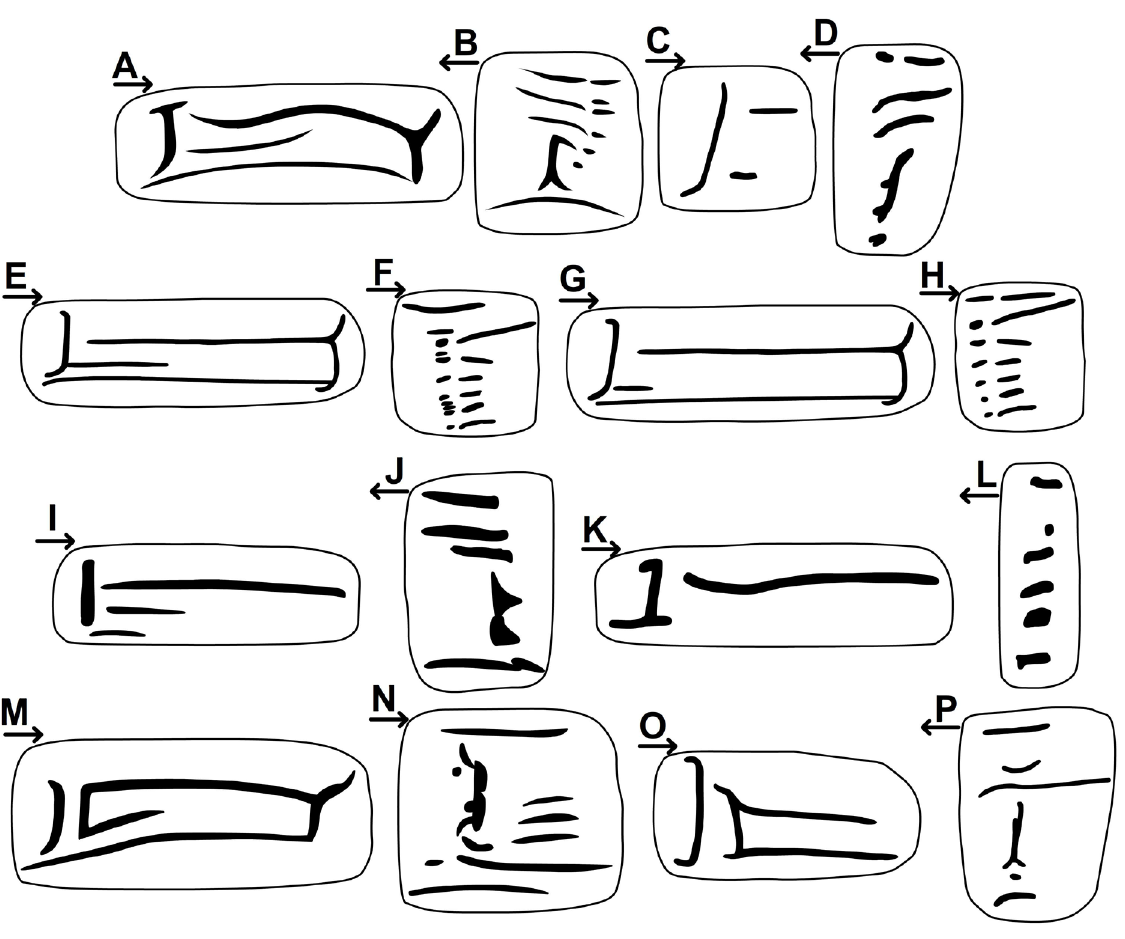
Fig. 24. Parietal (A, C, E, G, I, K, M, O) and palatal (B, D, F, H, J, L, N, P) plication of species of Chersaecia Gude, 1899. A–B . C. perrierae (Gude, 1898) (after Gude 1914b). C–D . C. refuga (Gould, 1846) (NHMUK 20170162). E–F . C. shanensis (Stoliczka, 1873), loc. 20091018B (coll. PGB). G–H . C. shanensis , loc. 20091018C (coll. PGB). I–J . C. shiroiensis shiroiensis (Godwin-Austen, 1875) (after Gude 1896a). K–L . C. shiroiensis subnagaensis subsp. nov., holotype (NHMUK 1903.7.1.753.1). M–N . C. woodthorpei (Gude, 1899) comb. nov. (after Gude 1914b). O–P . C. scabra sp. nov. (UF 380244). Arrows below the letters indicate the direction of the aperture. Not to